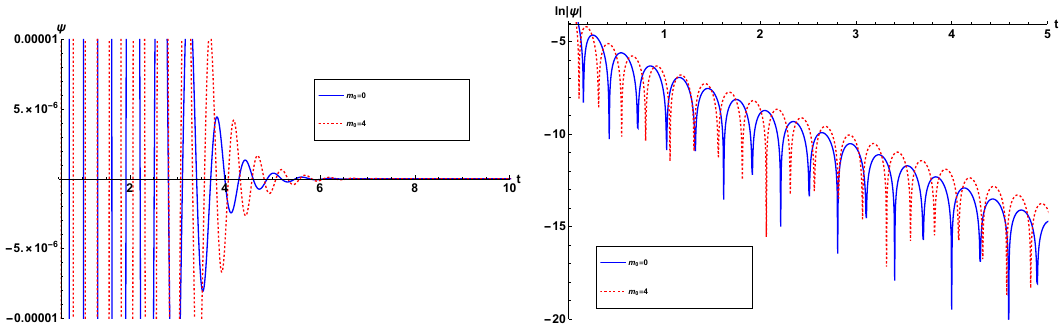
Figure 3 . Examples of field profile evolutions (left panel) and its logarithmic behavior (right panel). The geometry and field parameters read M = − Λ / 3 = α/ 0 . 12 = ‘/ 4 = 1